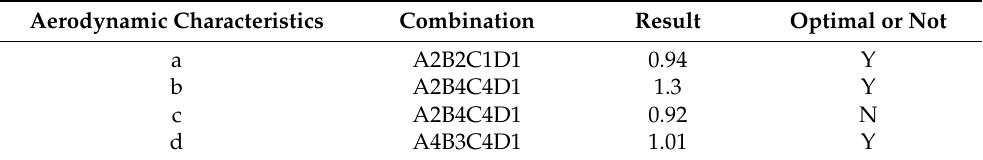
Table 6. Validation of rotor’s optimal sample combinations.